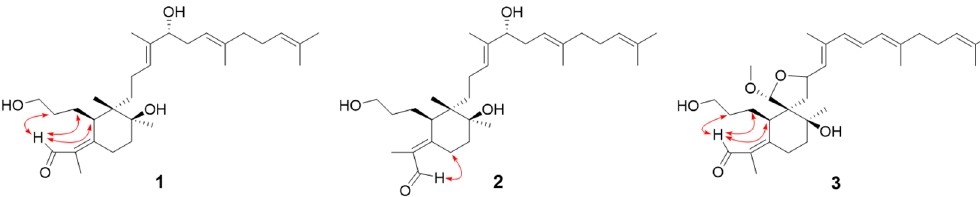
Figure 1. Structures of iridal-type triterpenoids from the roots of B. chinensis and their key NOESY correlations.